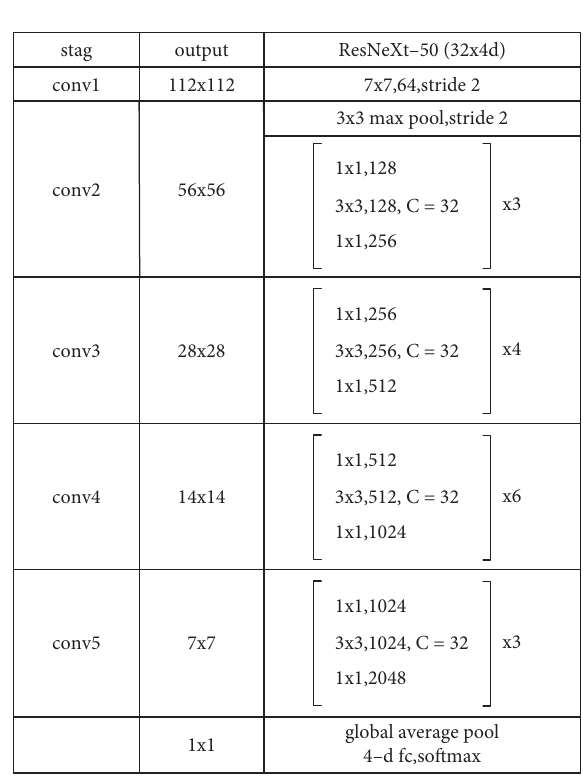
Figure 3: Structure of ResNeXt-50(32 × 4d)